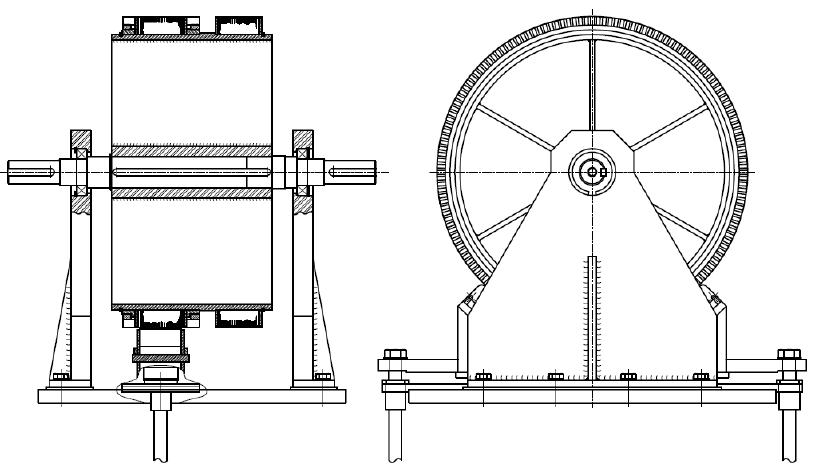
Figure 9. Prototype